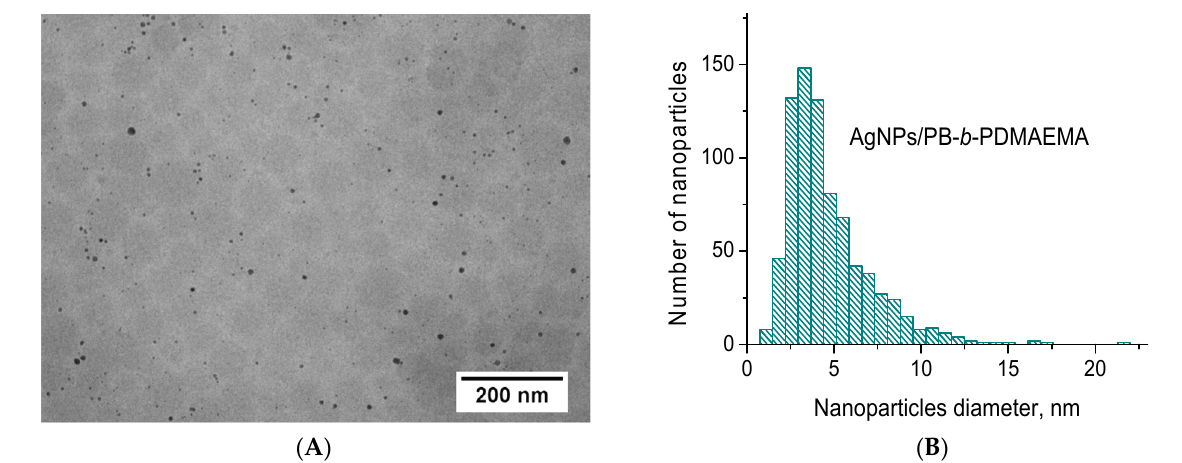
Figure 2. ( A ) The TEM image and ( B ) the corresponding size distributions of the AgNPs prepared in the presence of PB- b -PDMAEMA micelles.